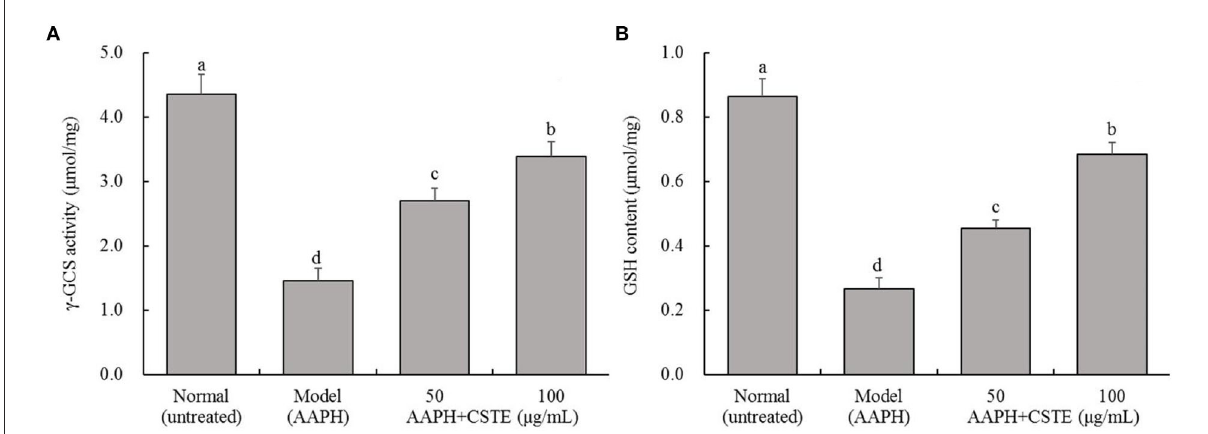
FIGURE5 γ -GCS activity and GSH content of AAPH inducing oxidative damaged HL-1 cardiomyocytes, (A) γ -GCS activity, (B) GSH content; CSTE: Clerodendranthus spicatus (Thunb.) C. Y. Wu extract. a − d according to Duncan’s multi range test, the average values of different letters in the same column have significant differences ( P < 0.05, n =